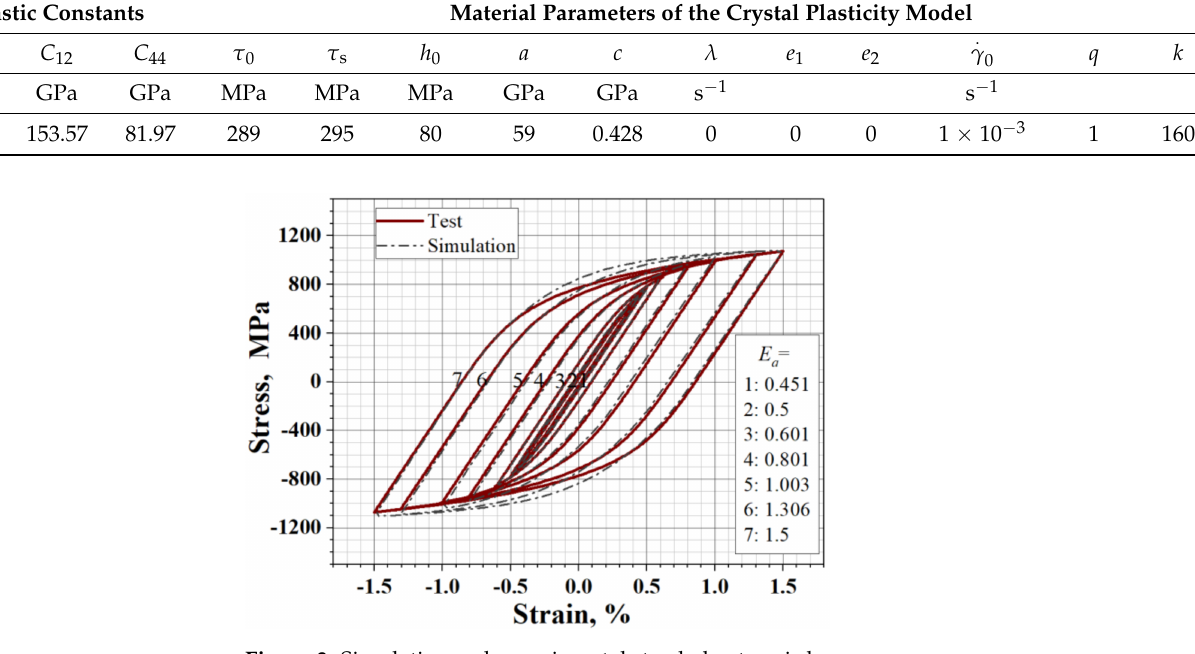
Figure 3. Simulative and experimental steady hysteresis loops.